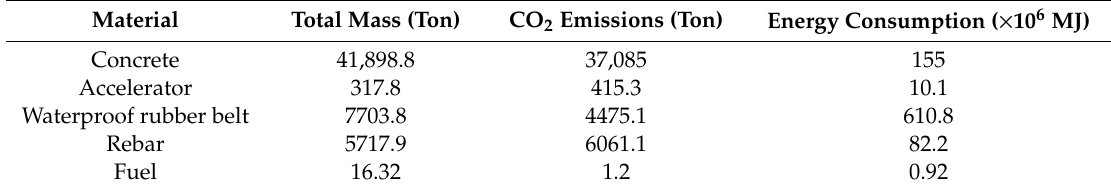
Table 7. CO 2 emissions and energy consumption of material production for tunnel